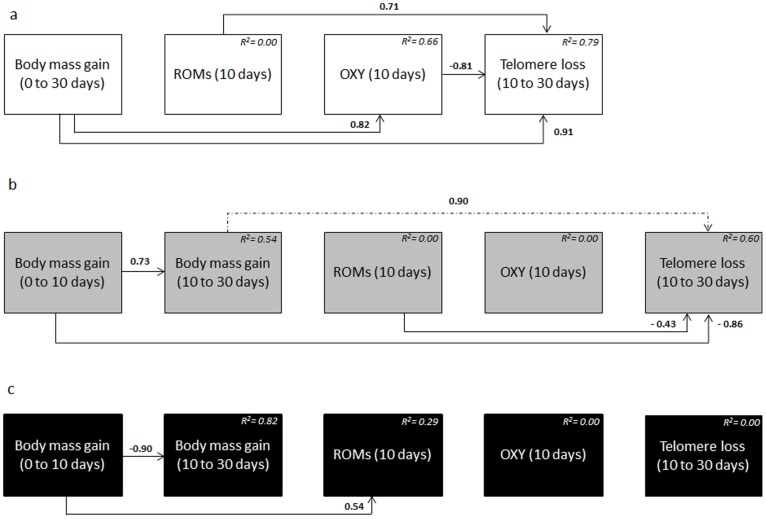
Path analysis diagrams for intra-group relationships between growth and ageing variables measured on chicks, in response to the hormonal treatment of the reproductive mothers.Control (a), E2 (b) and CORT group (c). Arrow represent causal link between variables, and standardized estimates (which can be positive or negative) are indicated along their respective paths. The total effect is the sum of direct and indirect effects. Significant paths are indicated by solid arrows while the dashed arrow represents a non-significant path remaining in the selected model. R2 is indicated in the box of each exogenous variable and represents the variation of the endogenous variable (i.e. body mass gain) explained by each corresponding exogenous variables. See text for statistical details. ROMs: reactive oxygen metabolites; OXY: plasma antioxidant capacities.